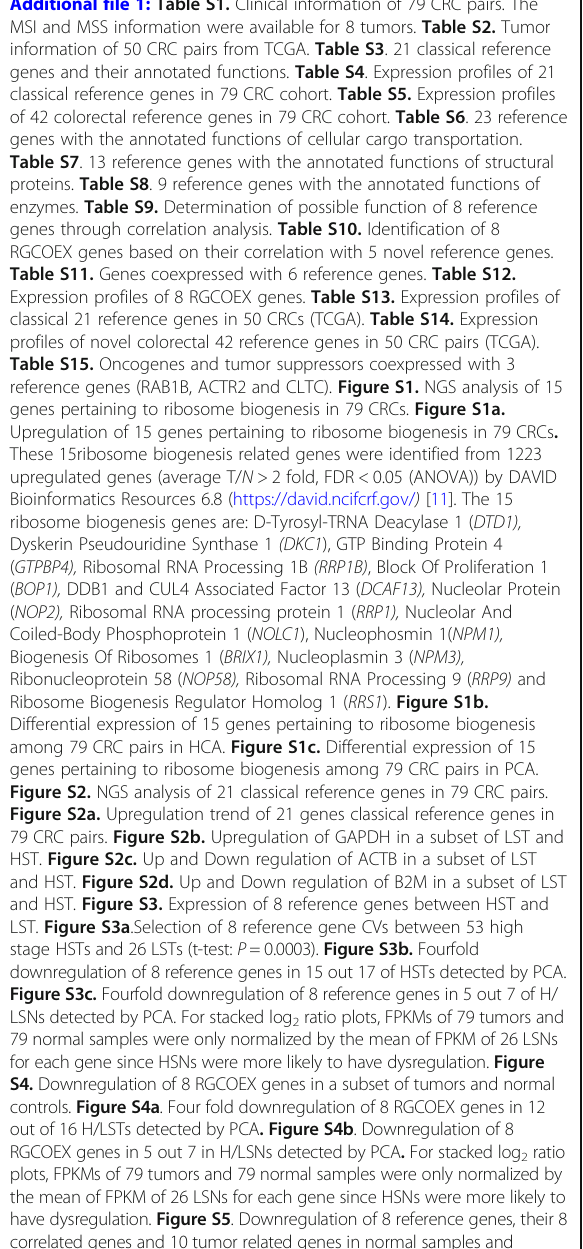
tumors. Figure S5a . Downregulation of 8 reference genes in 79 normal samples. Figure S5b . Downregulation of 8 reference genes in 79 tumors. Figure S5c. Downregulation of 8 RGCOEX genes in a subset of normal samples. Figure S5d. Downregulation of 8 RGCOEX genes in a subset of tumors. Figure S5e. Downregulation of 8 reference genes in 5 out 7 CRC pairs. Figure S5f. Downregulation of 8 RGCOEX genes in 5 out 7 CRC pairs . Figure S6. NGS analysis of tumor related genes in HSN. Figure S6a . Upregulation of COL6A1, COL6A2, COL1A2 and COL1A1 in N8. Figure S6b. Upregulation of CXCR1 and CXCR2 in N8. Figure S6c . Upregulation of MYC and CDK4 in N58. Figure S6d. Upregulation of MMP2 and MMP14 in N8. Figure S7 . PCA Simulated normalization of 15 ribosome biogenesis genes by 7 reference genes in 79 CRCs. Figure S7a . Ribosome biogenesis without normalization. Figure S7b . Ribosome biogenesis normalized by the hypothetical reference gene (FPKM =100 for all 158 samples, (CV=0%). Figure S7c . Ribosome biogenesis normalized by the C1orf43 (CV=16%). Figure S7d . Ribosome biogenesis normalized by the RAB7A (CV=17%). Figure S7e . Ribosome biogenesis normalized by the HEBP2 (CV=21%). Figure S7f . Ribosome biogenesis normalized by the ACTB (CV=34%). Figure S7g. Ribosome biogenesis normalized by the TFRC (CV=52%). Figure S7h. Ribosome biogenesis normalized by the HSP90AB1 (CV=75%). Figure S8. Weak agreement of 3 ribosome biogenesis gene expression profiles between NGS and qPCR in 20 CRC pairs. Figure S8a1 . Comparison of NGS and qPCR of BOP1. Figure S8a2 . Comparison of NGS and qPCR of DKC1. Figure S8a3. Comparison of NGS and qPCR of RRP1B. Figure S8b1 . Correlation of NGS and qPCR of BOP1. Figure S8b2 . Correlation of NGS and qPCR of DKC1. Figure S8b3 . Correlation of NGS and qPCR of RRP1B. Figure S9 . NGS analysis of 6 cancer hallmark genes expression in 50 CRCs (TCGA). Figure S9a . Upregulation of CCND1, CDK4 and MYC in 50 CRCs. Figure S9b . Downregulation of AQP8, GPX3 and CD177 in 50 CRCs. Figure S10. Co- downregulation of 3 reference genes with 3 tumor suppressors in 3 out of 6 H/SNs detected by PCA. (PPTX 3420